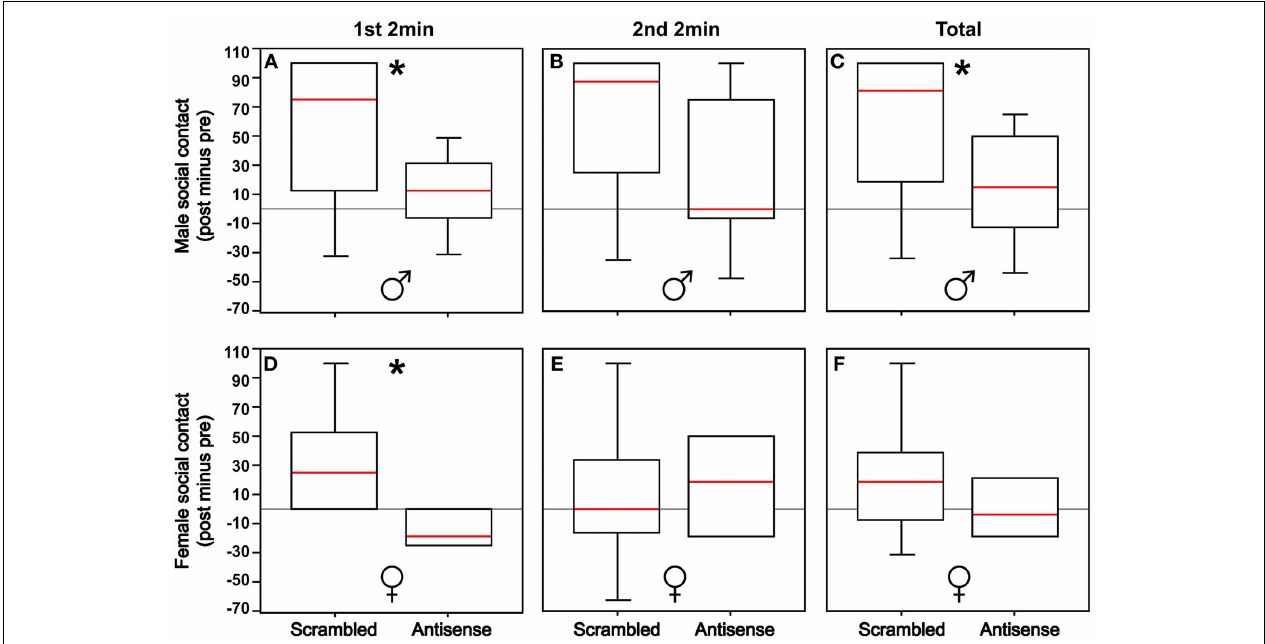
FIGURE 2 | (A,B) Knockdown of VT production in the BSTm reduces social contact in males in the first 2min of testing ( ∗ p = 0 . 03), but not in the second 2min of testing following the rotation of the stimulus cages containing 2 or 10 same-sex birds ( p = 0 . 13). (C) With the first and second test periods combined, there is an overall reduction in social contact in males ( ∗ p = 0 . 04). (D,E) Knockdown of VT production in the BSTm reduces